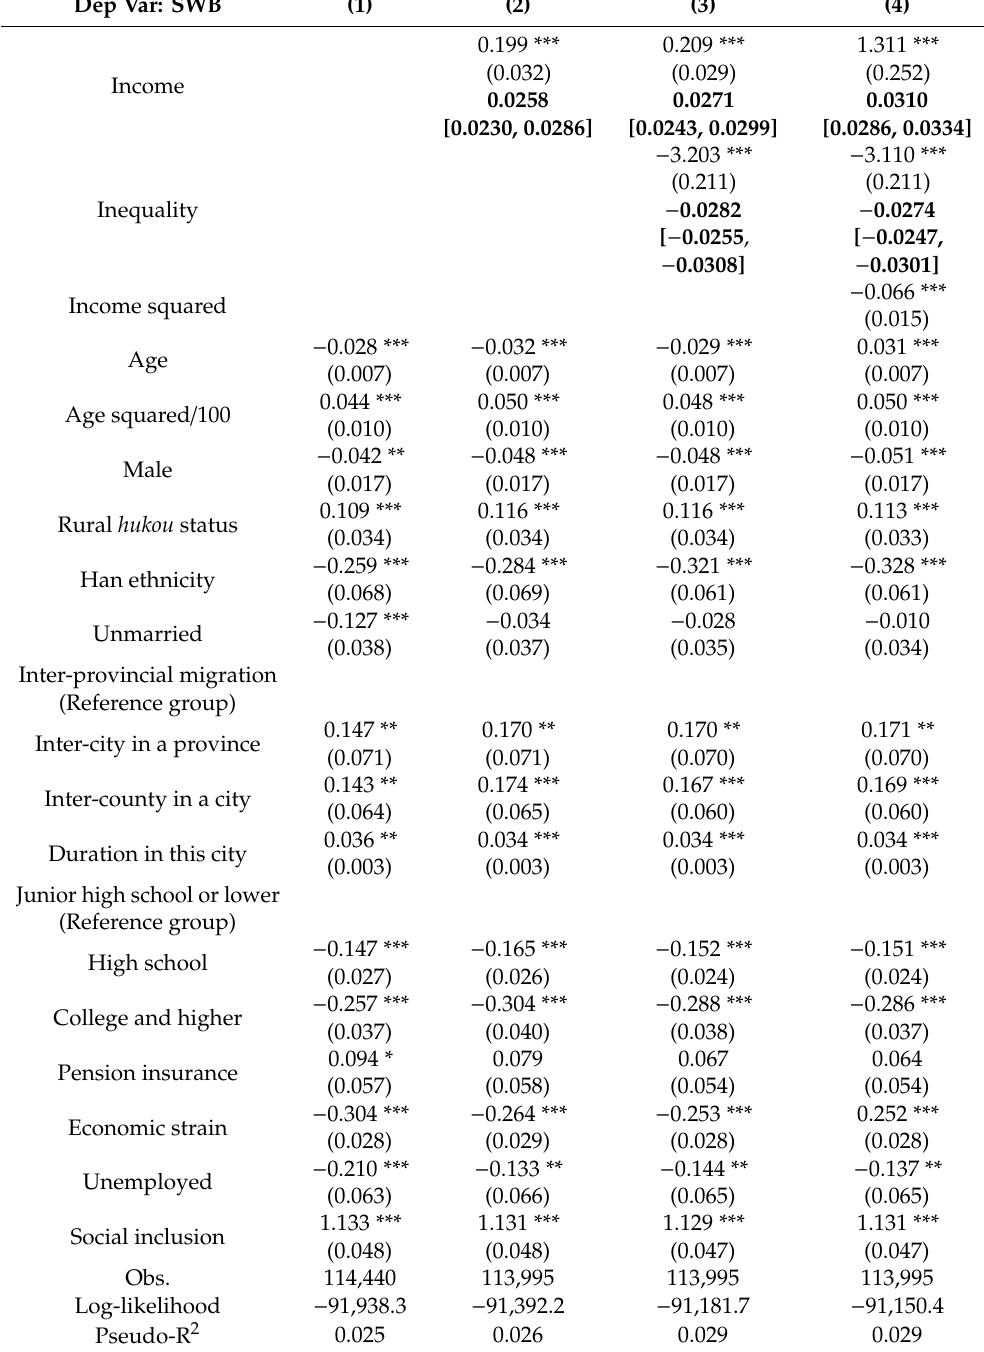
Table 3. Determinants of Migrants’ SWB: Full